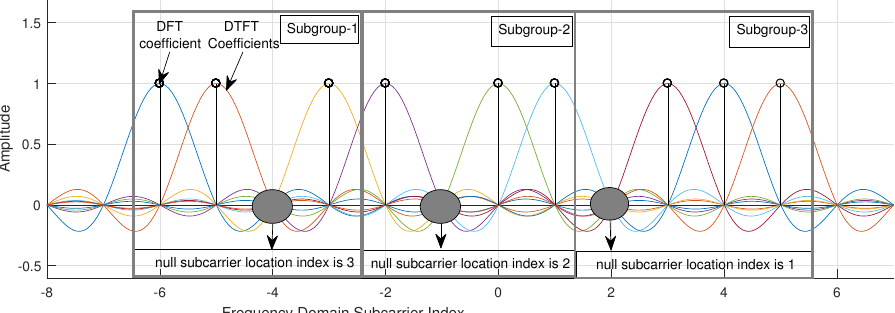
Figure 7. Frequency domain illustration of the modulated example